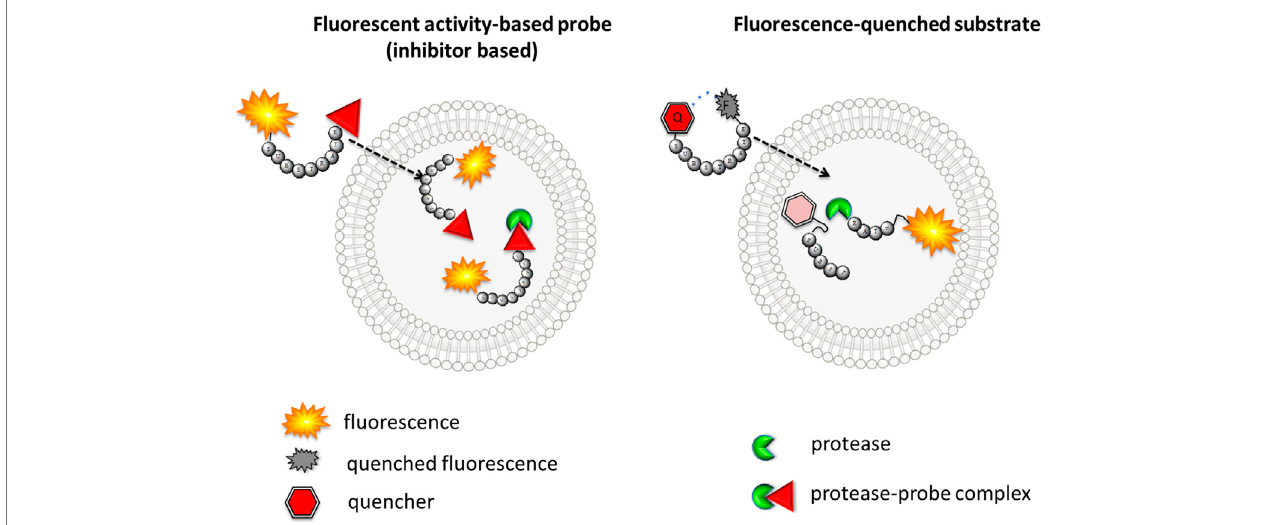
FIGURE 3 | The scheme of the cellular uptake of fl uorescence-quenched substrate and classic fl uorescent ABP. Left — inhibitor-based fl uorescent ABP is transported to the cell, and even fl uorescence from unbound probe can be detected. Right – substrate-based probe fl uorescence can be detected only if activated with the target protease.